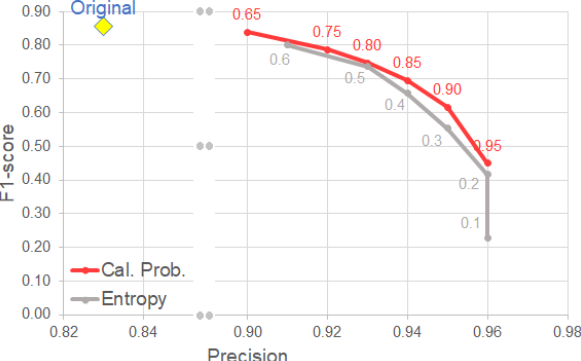
Figure 7. F1-Score vs. Precision plot using uncertainty selection for ESDB dataset. The performance is obtained by setting the predictions of the model to a negative detection if their uncertainty follows below the specified calibrated probability or entropy thresholds. The original model is WiderNet 8 × , FCN 128 with Bayesian approach and no selection. Please note that the curve produced by the cal. prob. is better than the entropy curve. Furthermore, a threshold of 0.65 on the cal. prob. yields almost no drop in F1-score but and 7% increase in precision. Best viewed in color.